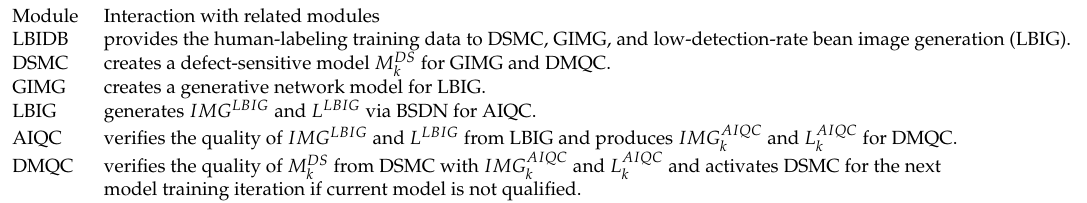
and L AIQC for DMQC. k k and L AIQC and activates DSMC for the next k k